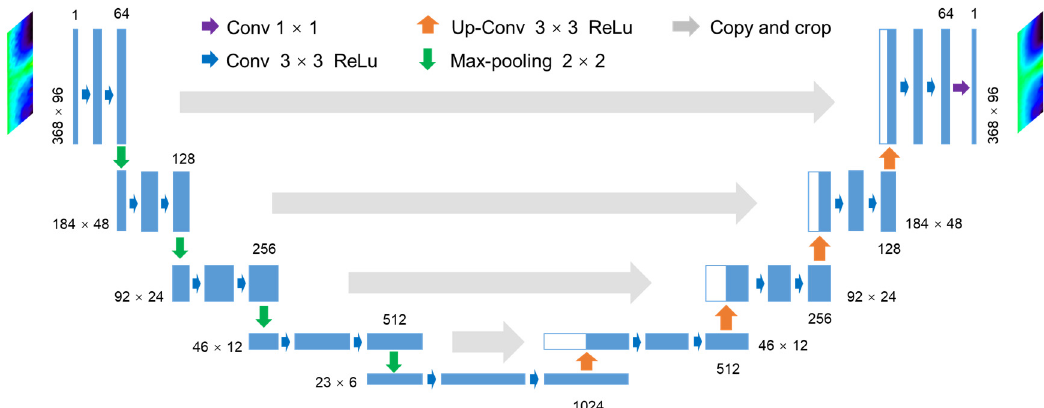
Figure 6. Architecture of the U-net network.